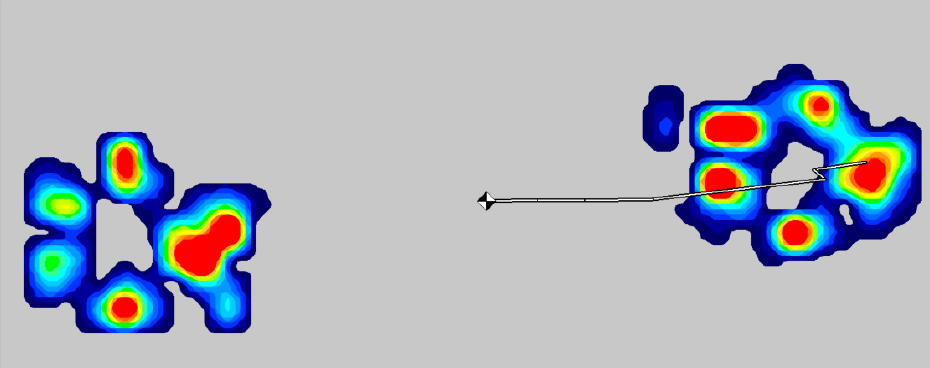
Figure 2. Tekscan ‘heatmat’ visualisation of peak vertical landing force (N). Colours provide a visual representation of measured forces from low (blue) to high (red). The black and white symbol indicates the centre of gravity at the point of measurement.